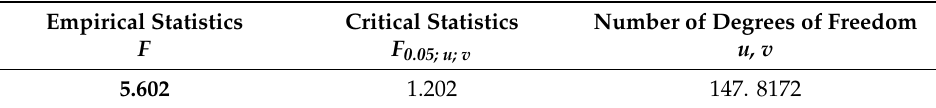
Table 10. One-way analysis of variance (at significance level p = 0.05) for distribution of average densities on the longitudinal section of birch logs.